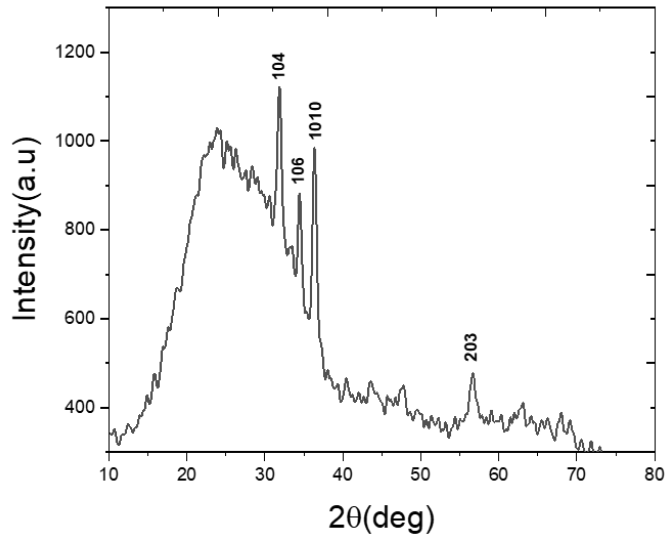
Figure 2. X-ray diffraction patterns of ZnS Narcissus-Like nanostructured thin films. Prepared at Td = 65 ˚C pH = 10, t = 10 min. Zn conc. = 0.2 M, Tu-conc. = 0.2 M.